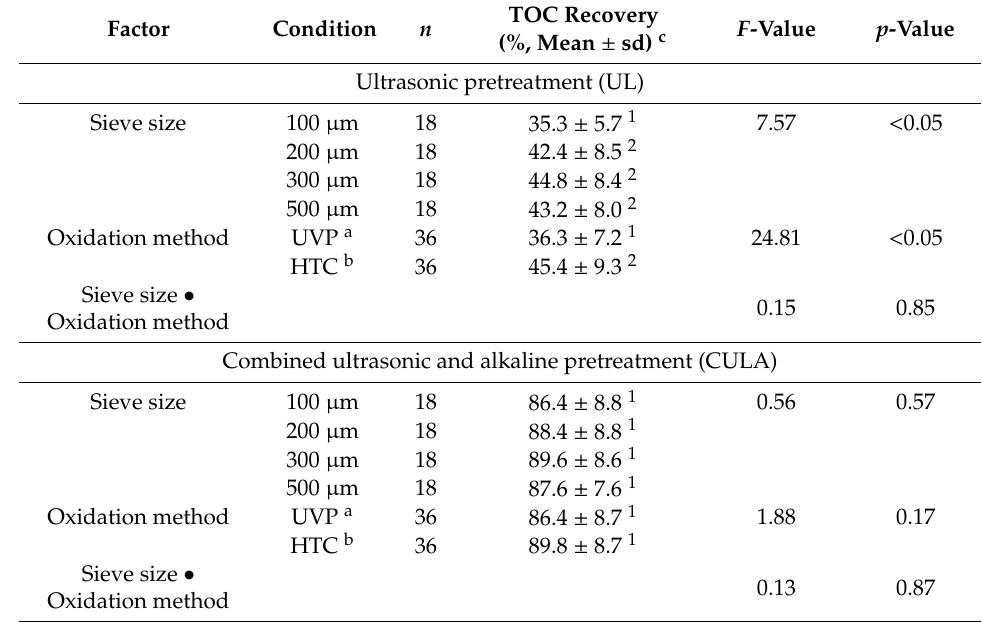
Table 2. Summary of two-way analysis of variance (ANOVA) for total organic carbon (TOC) recovery (%) by sieve size and oxidation method for each pretreatment